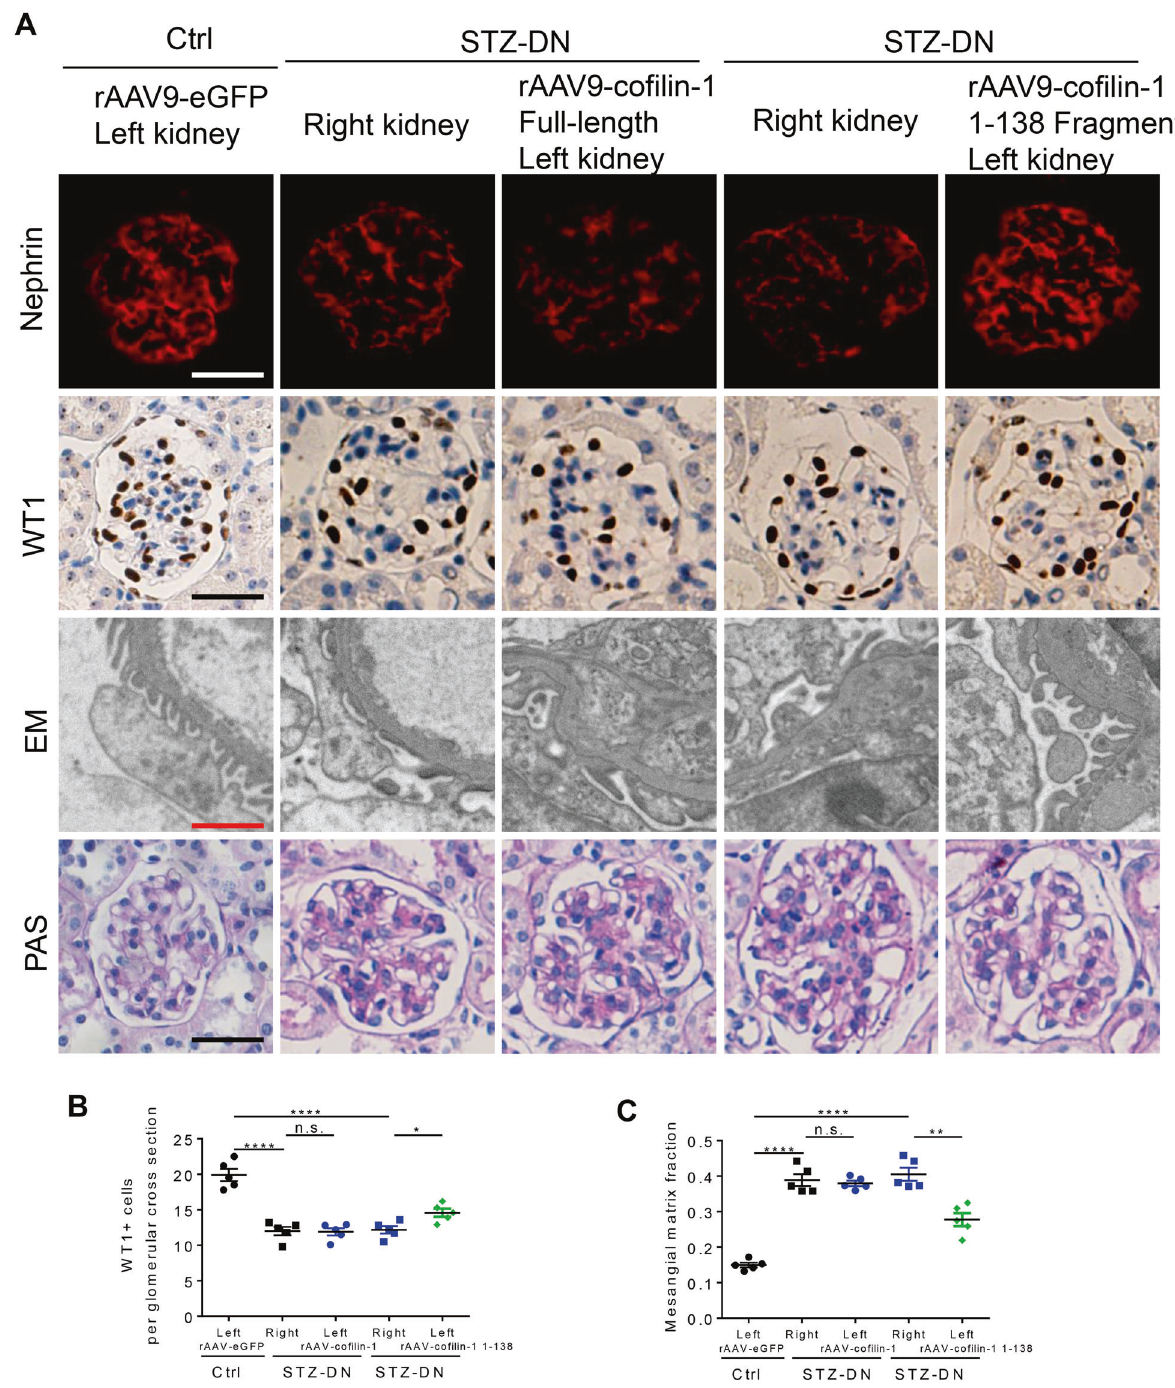
Fig. 8 Induction of co fi lin-1 1-138 fragment in podocytes improved podocyte injury and renal damage in streptozotocin (STZ)-induced diabetic nephropathy (DN). A Representative image showing Nephrin and WT1 immunostaining, podocyte foot process and glomerular basement membrane (GBM), and glomerular morphological changes in different groups of mice. White and black scale bar: 25 μ m; red scale bar: 2 μ m. B Quanti fi cation of WT1-positive cells. N = 5. C Quantitative analyses of the percentage of mesangial matrix area. N = 5. **** P < 0.0001, ** P < 0.01, * P < 0.05, n.s. no signi fi cance, data were represented as mean ± immunoactivity of the antiserum was further con fi rmed by western blotting and immunohistochemistry. generated co fi lin-1 fragment (anti-co fi lin-1 N138) The rabbits were immunized with the peptide Ac-TGIKHELQAN-OH, which includes the nine amino acids in co fi lin-1 preceding the AEP cleavage site Western blotting at N138. The antiserum was pooled and the titers against the immunizing The total protein lysates of cultured cells and kidney tissues were prepared peptide were determined by ELISA. The maximal dilution giving a positive and western blot analysis were performed as described previously [36]. The response using the chromogenic substrate for HRP was 1:30 000. The